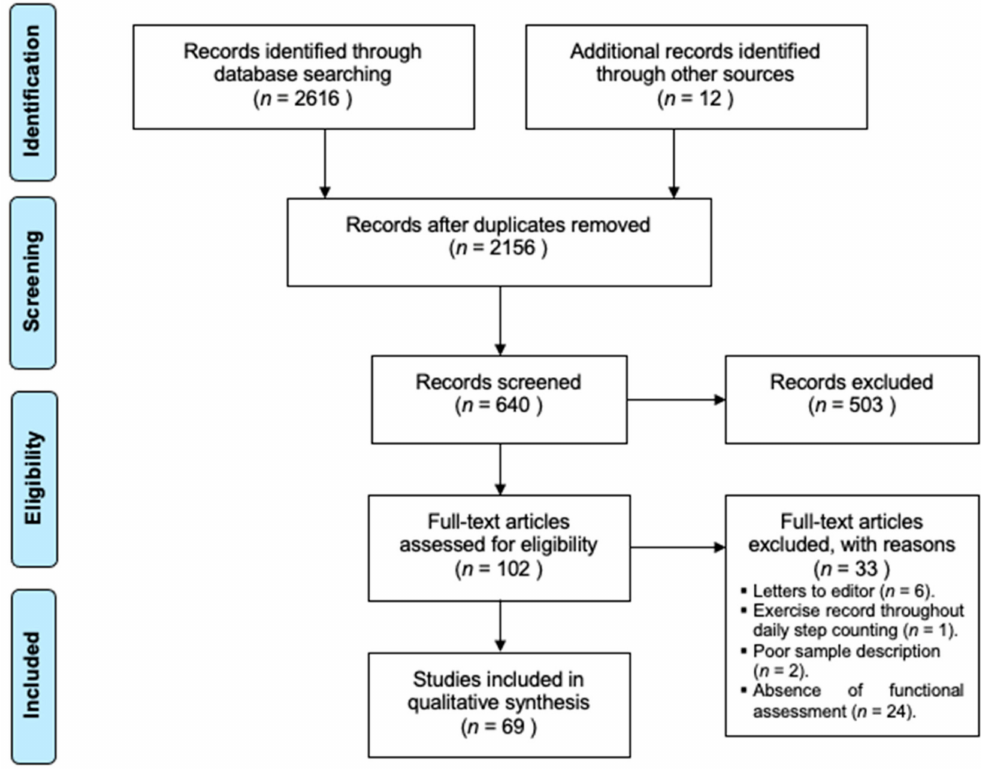
Figure 1. Flow diagram of the search process. Adapted from Moher and collaborators